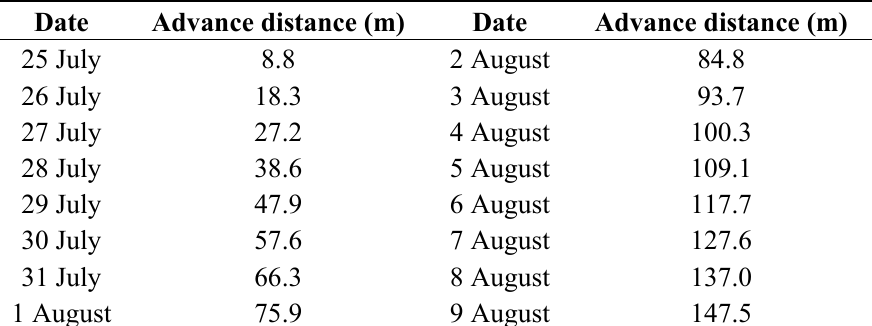
Table 3. Advance distance of the 6203# coalface each day.